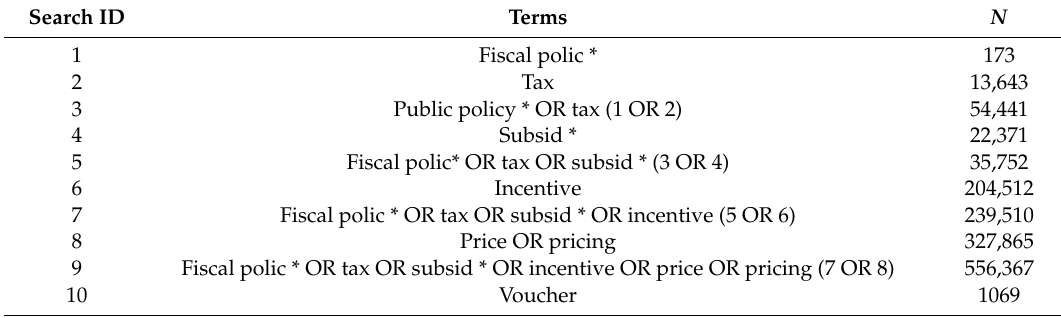
Table 2. Description of the search strategy in